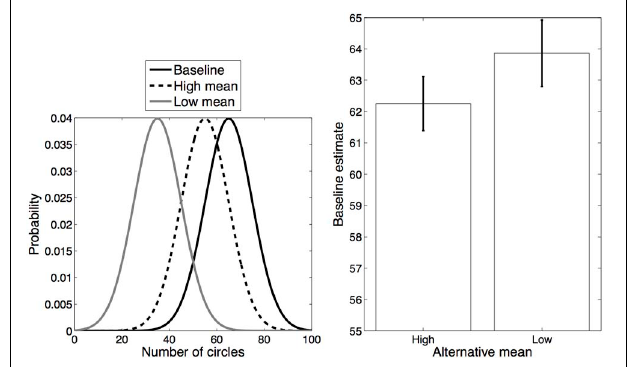
FIGURE 2 | Experiment 1 design and results. Left : Distributions for each category. Right : Average estimates for the baseline category in each condition. Error bars represent standard error of the